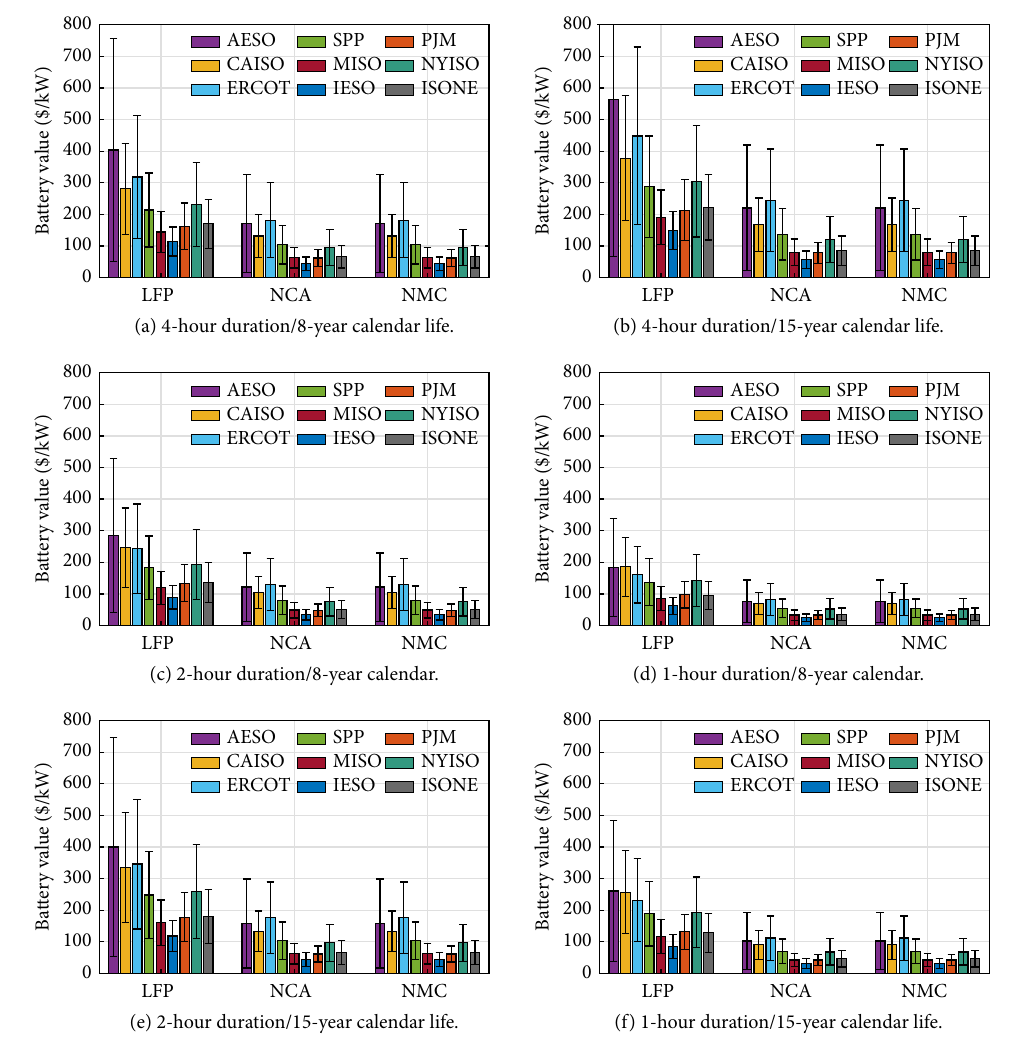
Fig. 4 Synthesis of battery value estimation per kW battery storage capacity assuming: (a) 4-hour duration/8-year calendar life, (b) 4-hour duration/15-year calendar life, and (c) 2-hour duration/8-year calendar life, (d) 1-hour duration/8-year calendar life, (e) 2-hour duration/15-year calendar life, (f) 1-hour duration/15-year calendar